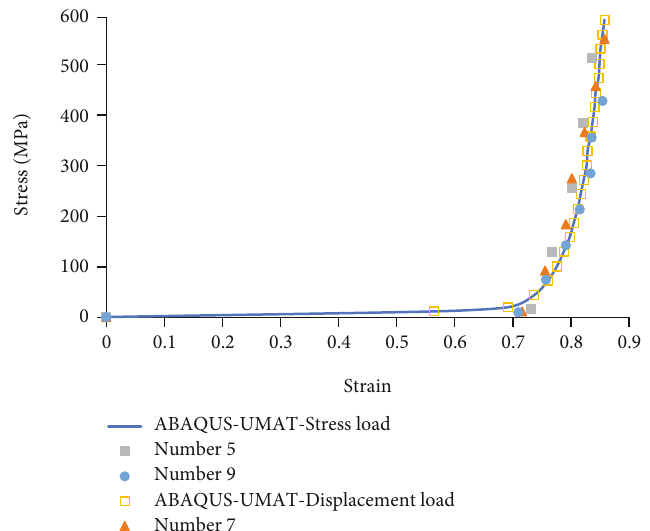
Figure 9: Results of numerical veri fi cation (initial height of proppant column: 10